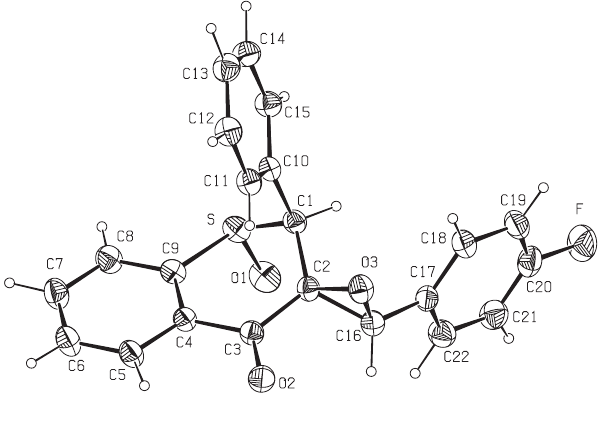
Table 2. Atomic coordinates and displacement parameters (in Å 2 )